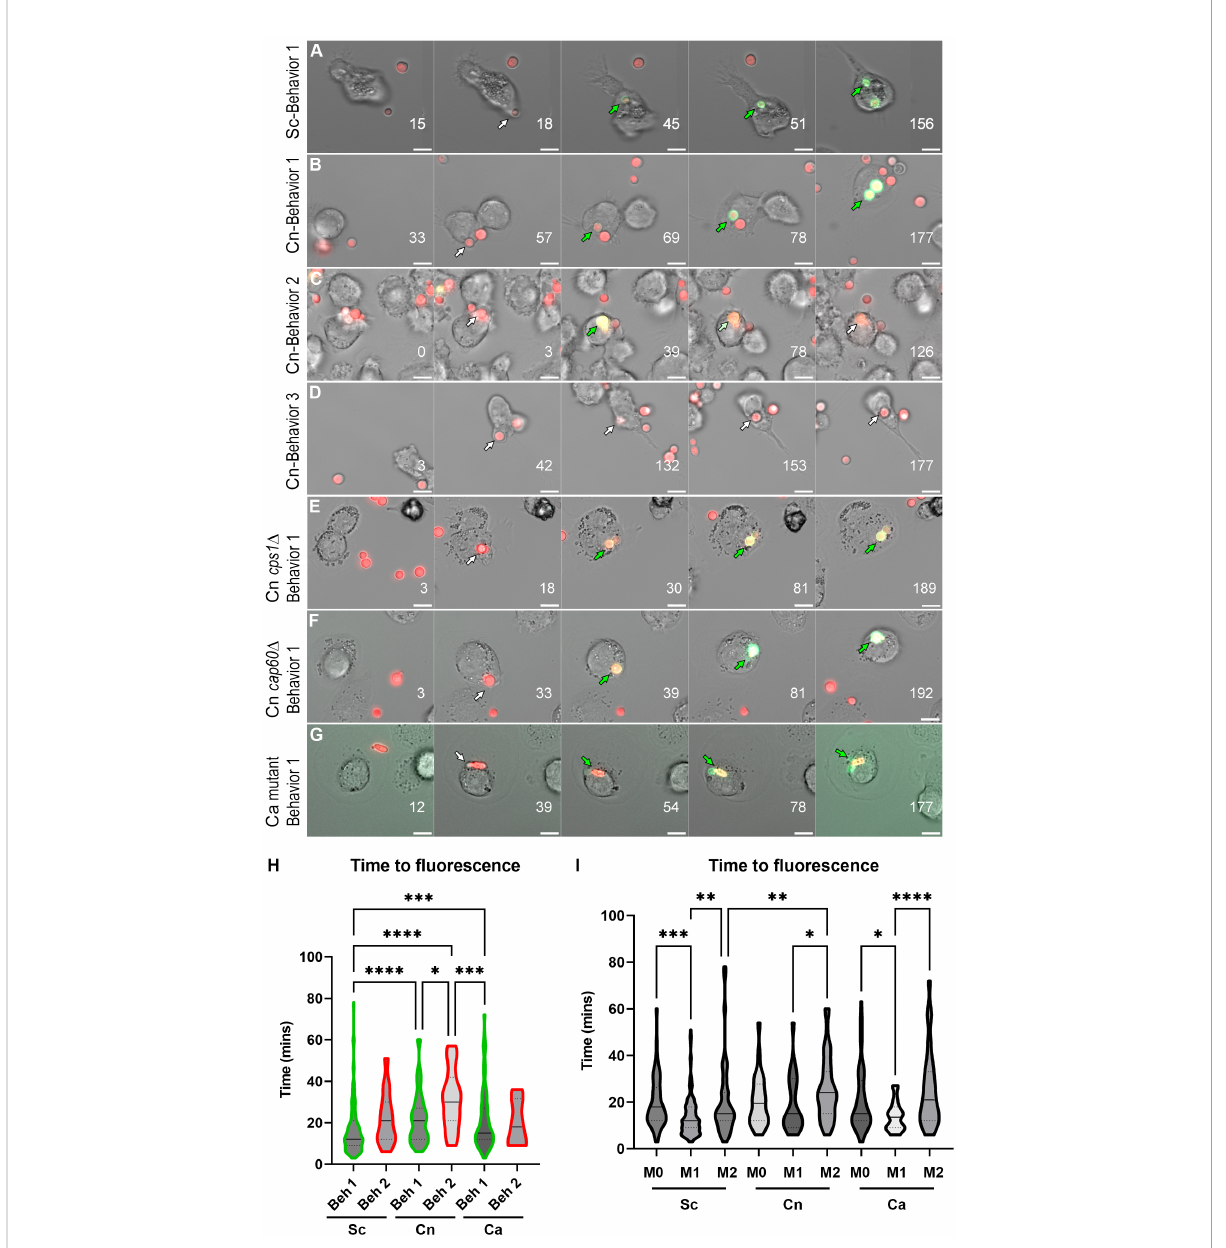
FIGURE 1 Behaviors and kinetics of phagosomal acidi fi cation in fungi-infected THP-1 cells. (A) Stills from a representative video showing the main behavior (behavior 1) in S. cerevisiae (Sc)-infected THP-1 cells. For the complete video see Video S1. (B) Stills from a representative video showing behavior 1 in C neoformans (Cn)-infected THP-1 cells. For the complete video see Video S2. (C) Stills from a representative video showing behavior 2 in Cn- infected THP-1 cells. For the complete video see Video S3. (D) Stills from a representative video showing behavior 3 in Cn-infected THP-1 cells. For the complete video see Video S4. (E) Stills from a representative video showing behavior 1 in THP-1 cells infected with Cn mutant cps1 D . For the complete video see Video S5. (F) Stills from a representative video showing behavior 1 in in THP-1 cells infected with Cn mutant cap60 D . For the complete video see Video S6. (G) Stills from a representative video showing behavior 1 in THP-1 cells infected with yeast-locked C albicans (Ca). For the complete video see Video S7. Numbers on lower right represent the time in minutes. The arrows point to the same fungus and are white when non fl uorescent in the pHrodo channel and green when fl uorescent. Scale bar = 10 m m. (H) Violin plots showing the kinetics and distribution of behaviors in THP-1 cells infected by Sc, Cn, or Ca. For this analysis, all behavior 1 or behavior 2 events throughout all polarization states were combined. The solid line represents the median, and the dashed lines the quartiles. (I) Violin plots showing the kinetics and distribution of behaviors in THP-1 cells infected by Sc, Cn, or Ca. For this analysis, all behaviors events per polarization state were combined. The solid line represents the median, and the dashed lines the quartiles. See Table S1 for mean and standard deviation values. Violin plots were analyzed by one-way nonparametric ANOVA test, with multiple comparisons (Kruskal-Wallis test). *, P < 0.05; **, P < 0.01; ***, P < 0.001; ****, P <